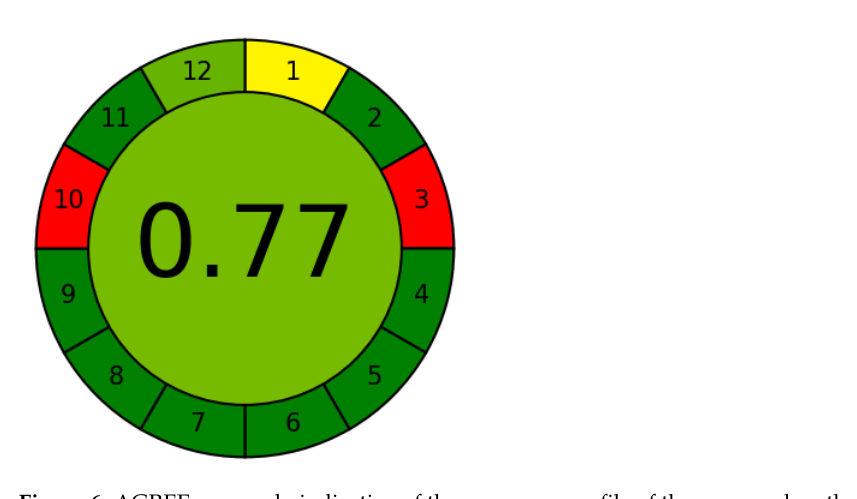
Figure 6. AGREE approach, indicative of the greenness profile of the proposed method for the rapid assay of